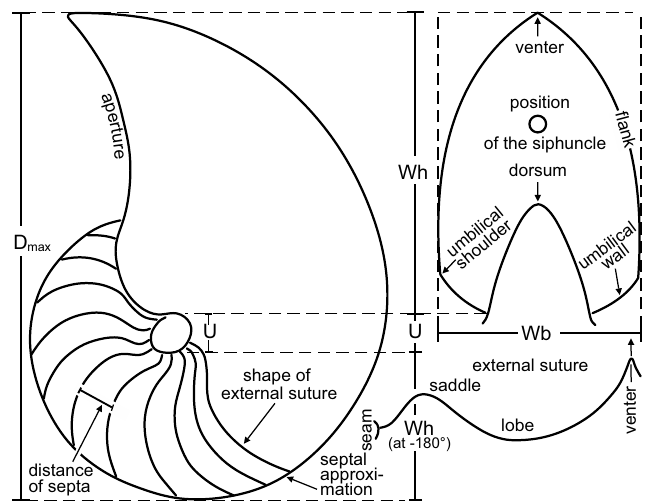
Fig. 2. Shell parameters, suture terminology, and biometric factors of the planispiral nautiloid shell (modified after Wilmsen 2016). Abbreviations: D max , maximum diameter; U, umbilical width at D max ; Wb, whorl breadth at D max ; Wh, whorl height at D max